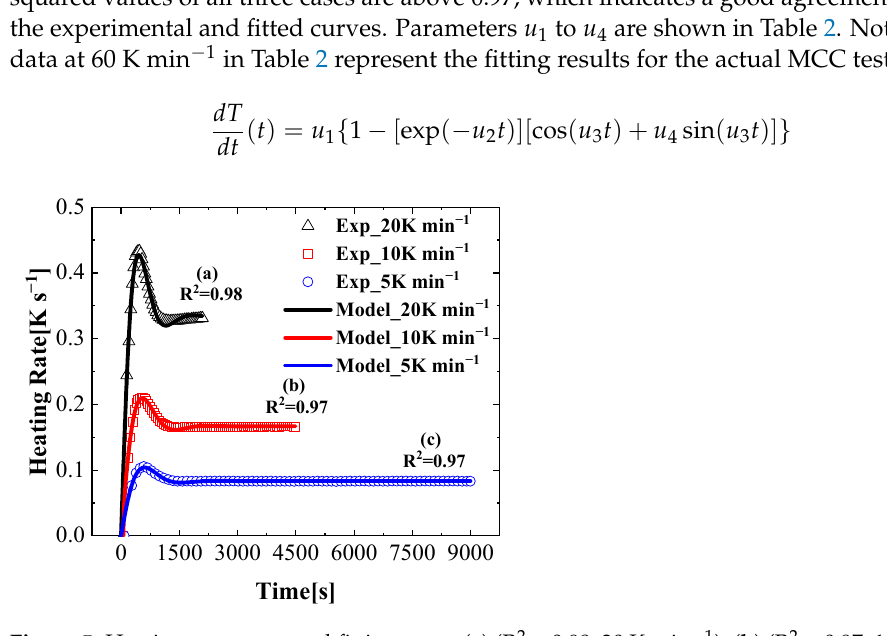
Figure 5. Heating rate curve and fitting curve ( a ) (R 2 = 0.98, 20K min − 1 ), ( b ) (R 2 = 0.97, 10K min − 1 ) and ( c ) (R 2 = 0.97, 5K min − 1 ).